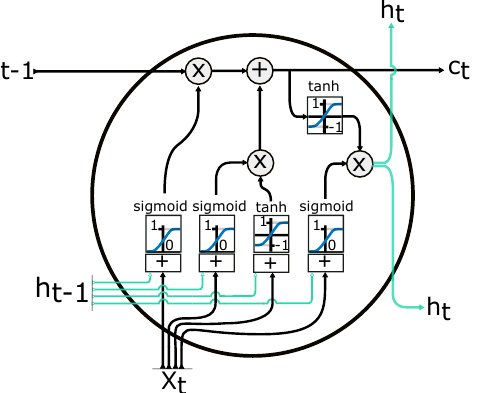
Figure 9. RNN LSTM cell. X t —input vector; c t —memory from current cell; c t − 1 —memory from previous block; h t —output from current cell; h t − 1 —memory from previous cell; ( (cid:78) ) —element-wise multiplication; ( (cid:76) ) —element-wise summation/concatenation. Adapted from